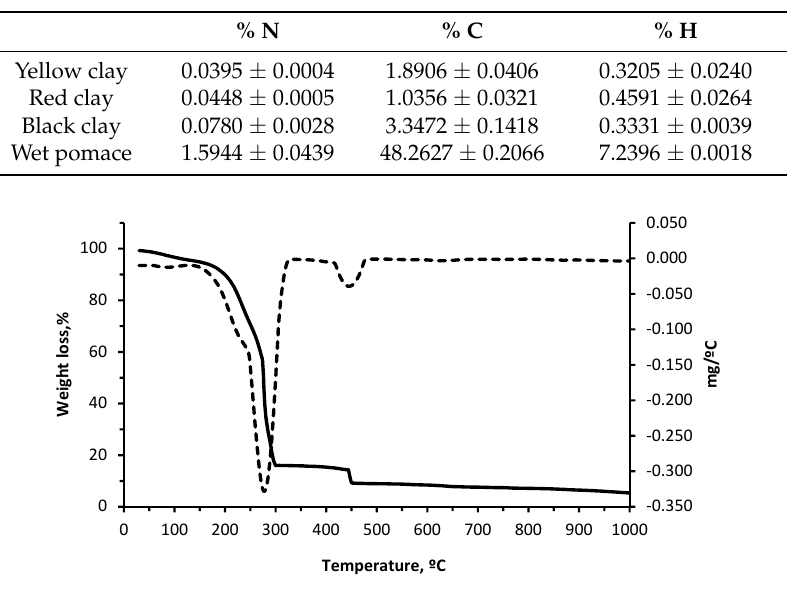
Figure 4. Thermogravimetric/ differential thermogravimetric (TG-DTG) curves of wet pomace.